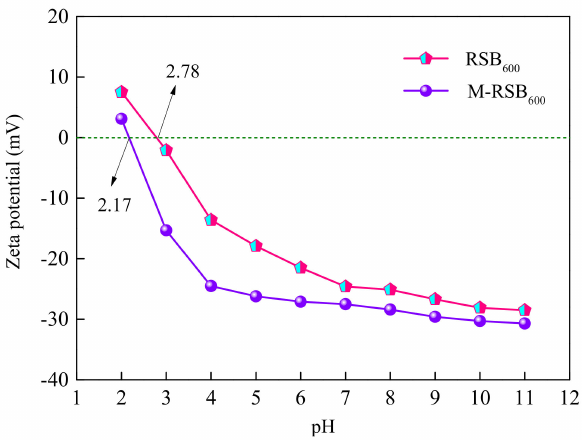
Figure 5. Zeta potential at different pH